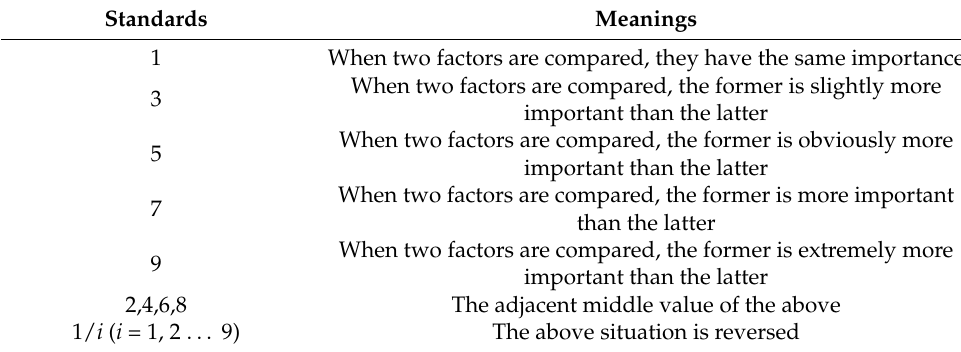
Figure 6. Flowchart of AHP. Table 3. Standards and meanings of judgment matrix.